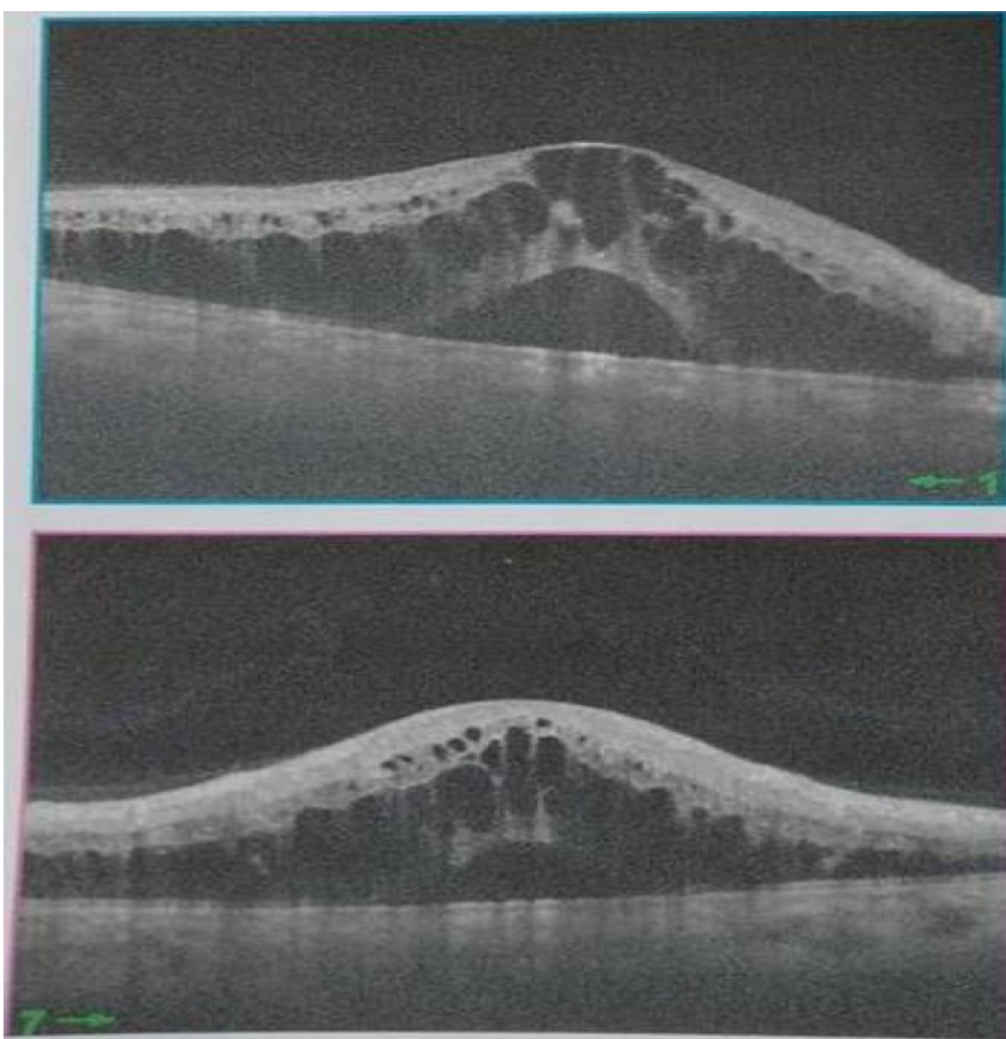
Figure 3. Spectral-domain optical coherence tomography showing cystoid macular